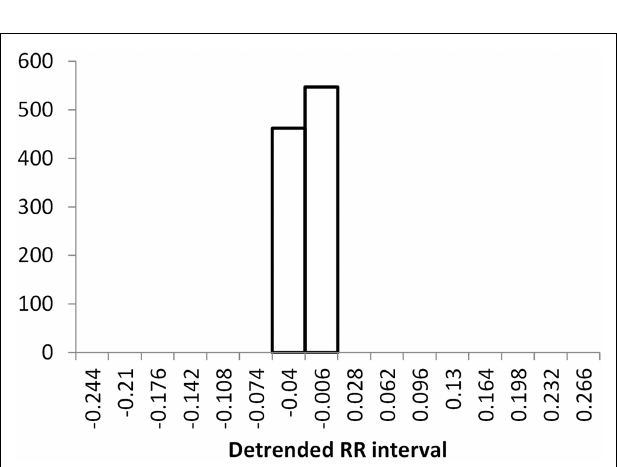
FIGURE 3 | Histograms of the detrended RR intervals for participants in the Early CAN group made using the same bin divisions for all data used .The vertical axis shows the count of RR intervals falling into each bin. The SD is 0.038.